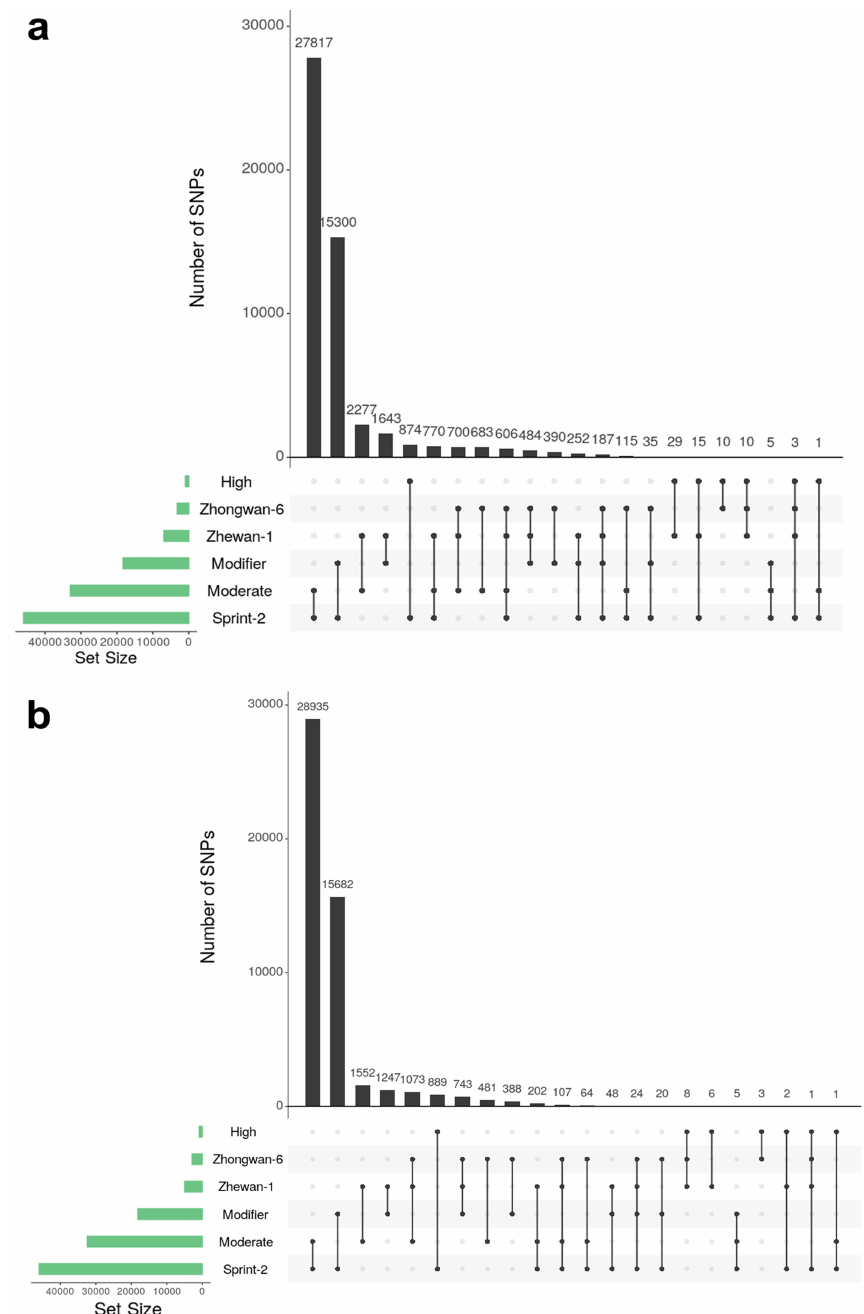
Figure 13. Representation of common and unique variants in three pea cultivars. Vertical bars indicate the numbers of variants falling in the respective intersection. Horizontal bars indicate absolute numbers of variants in the stated cultivar or with the stated e ff ect. ‘High’, ‘Moderate’, and ‘Modifier’ categories refer to the respective variant e ff ects according to snpE ff 2 notation. Vertical lines link cultivars and variant e ff ects denoting respective variant intersections. ( a ) Intersection of heterozygous sites found in Sprint-2 with homozygous variants from Zhewan-1 and Zhongwan-6. ( b ) Intersection of heterozygous variants from all three studied